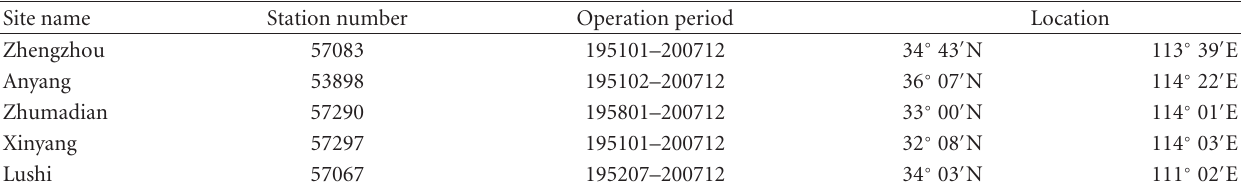
Figure 1: Distribution of stations, named Anyang, Zhengzhou, Lushi, Zhumadian, and Xinyang. Table 1: Observation sites with station number, corresponding time periods estimated, and